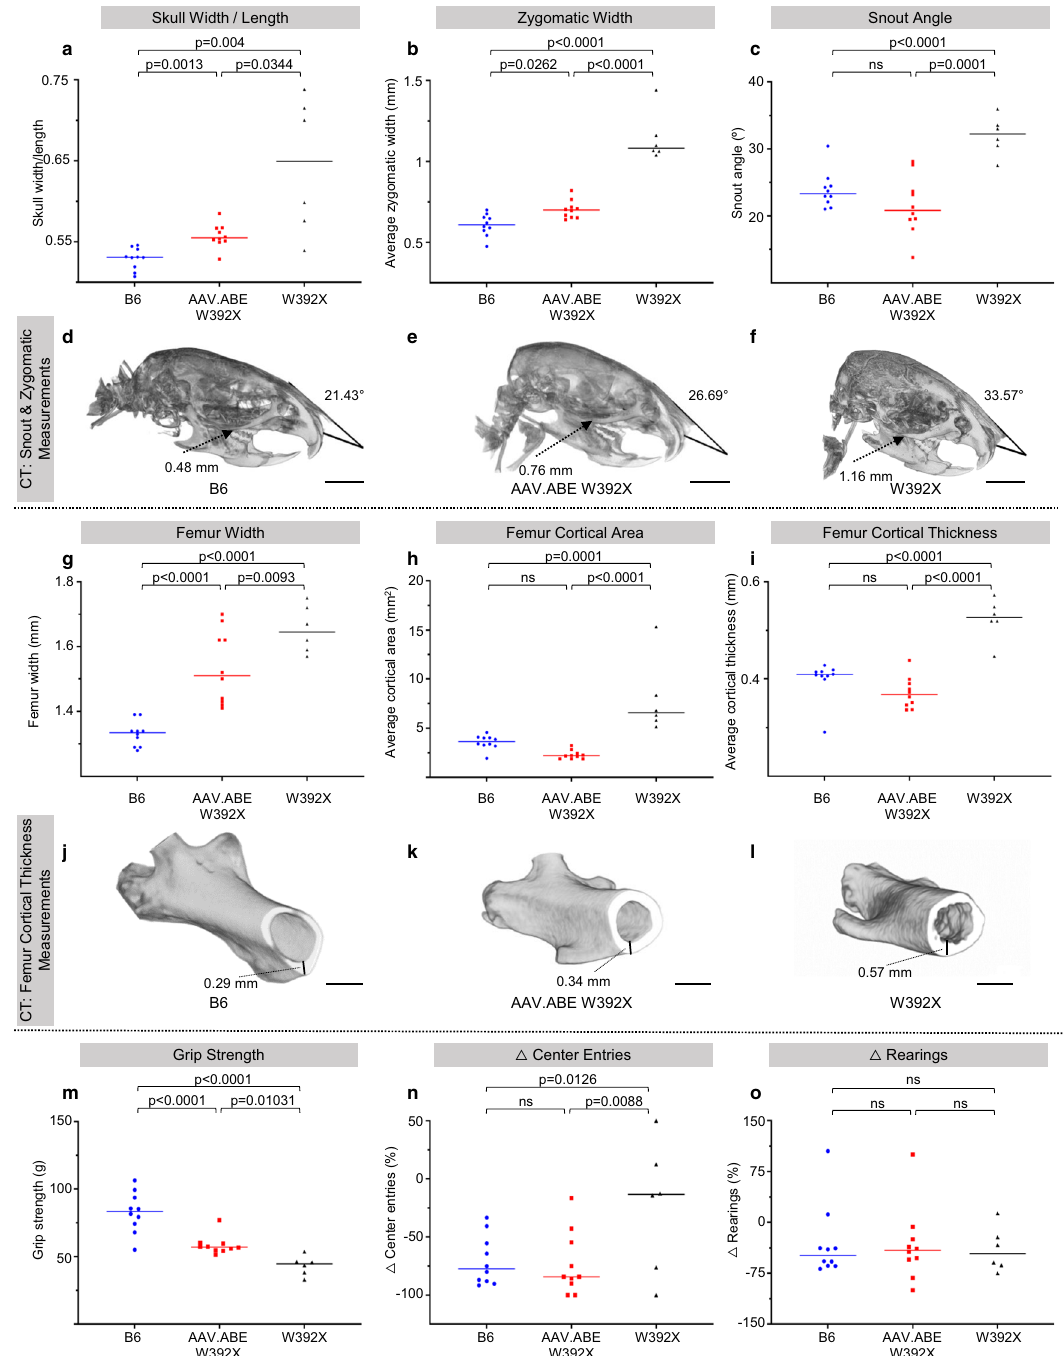
Fig. 5 In utero base editing improves the musculoskeletal and neurobehavioural phenotype in Idua-W392X mice. a – c CT face parameters were measured in 6-month-old B6 ( N = 10), 6-month-old Idua- W392X mice prenatally injected with AAV.ABE.Idua ( N = 10), and surviving uninjected Idua- W392X mice ( N = 6). d – f 3D CT reconstructions of representative skulls from 6-month-old B6, prenatally injected mice, and surviving uninjected mice with snout angle and zygomatic arch measurements indicated. Scale bar = 5 mm. g – i CT femur parameters were measured in 6-month-old B6 ( N = 10), prenatally injected mice ( N = 10), and surviving uninjected mice ( N = 6). j – l 3D CT reconstructions of representative femurs from 6-month-old B6, prenatally injected mice, and uninjected mice demonstrating cortical thickness measurements and surface contour. Scale bar = 1 mm. m Grip strength was measured in 6-month-old B6 ( N = 10), prenatally injected mice ( N = 10), and surviving uninjected mice ( N = 6). n , o Open fi eld test measurements of habituation between trials of testing in 6-month-old B6 ( N = 10), prenatally injected mice ( N = 10), and surviving uninjected mice ( N = 6) Δ re fl ects change in parameter between the fi rst and third trial. Wilcoxon test for multiple comparisons was used to assess skull width/thickness; Student ’ s t -test used for all other comparisons; α = 0.05. All tests two-sided. CT computed tomography scan. AAV.ABE indicates AAV.ABE.Idua. Source data are provided as a Source Data fi